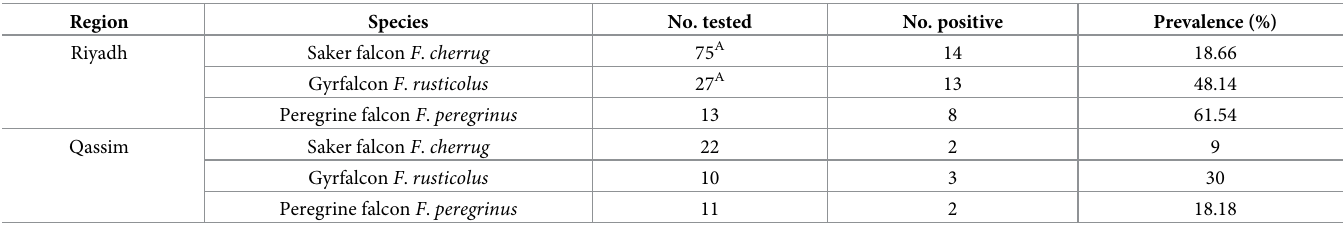
Table 1. Trichomonas gallinae prevalence in falcons.